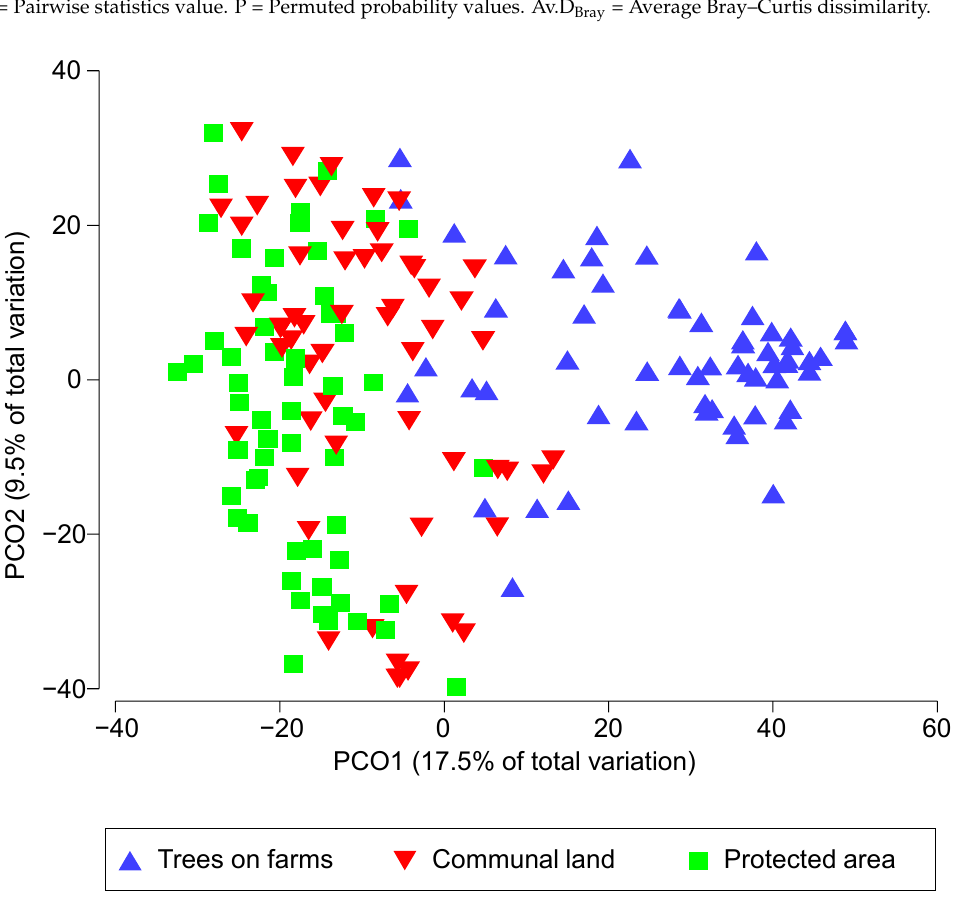
Figure 4. Principal Component Analysis (PCO) of species richness variation between different land-uses in the study areas.